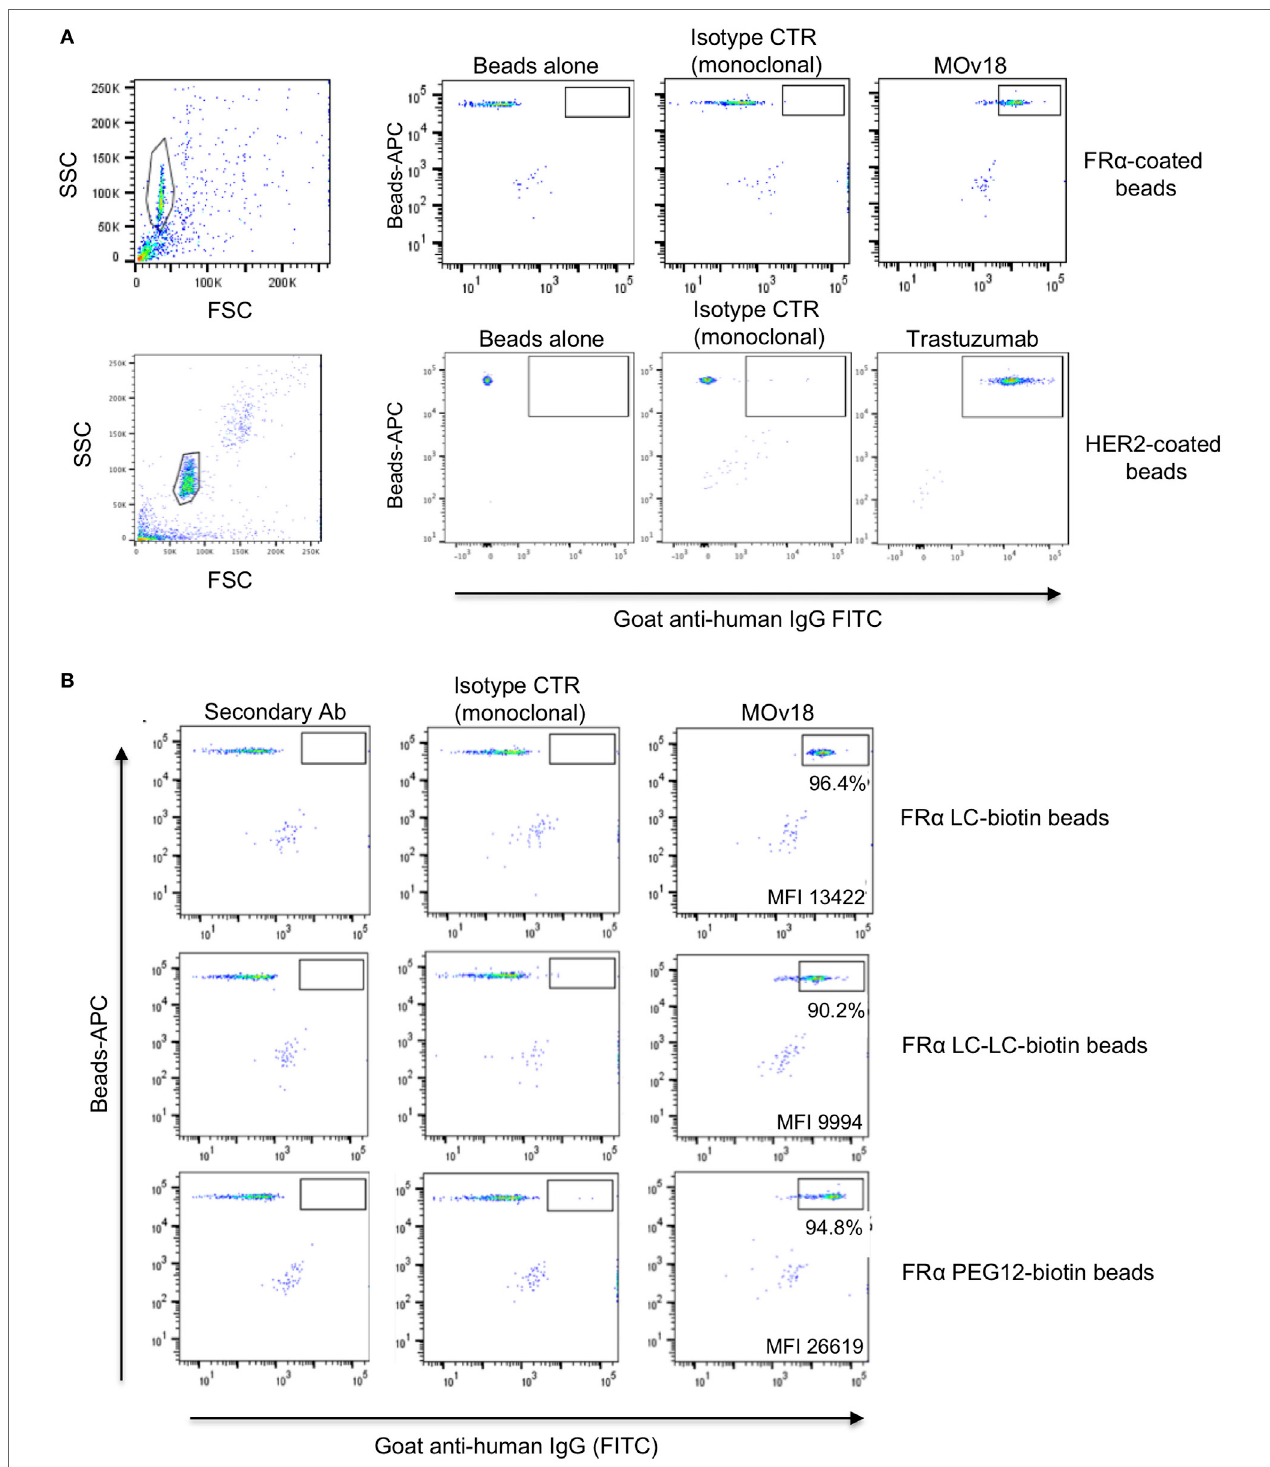
FigUre 2 | Antigen-coated beads were recognized by specific antibodies. (a) Fluorescent microspheres (SA-Blue 1.1 µm) coated with human recombinant FR α (top) or HER2 (bottom) conjugated to LC-LC-biotin were incubated with no antibody, non-specific monoclonal anti-NIP (control), MOv18 (top right), or anti-HER2 antibodies (bottom right). Bead-bound antibodies were detected using secondary goat anti-human FITC-conjugated antibodies. Gates indicate positive antibody staining above controls. (B) Recombinant FR α conjugated to biotin of different arm lengths was used to coat fluorescent LumAvidin 5.6 µm microspheres, and microspheres were stained with MOv18 IgG1 antibody. The percentage of MOv18 IgG1-bound beads and mean fluorescence intensity (MFI) values of positive populations are indicated in each dot